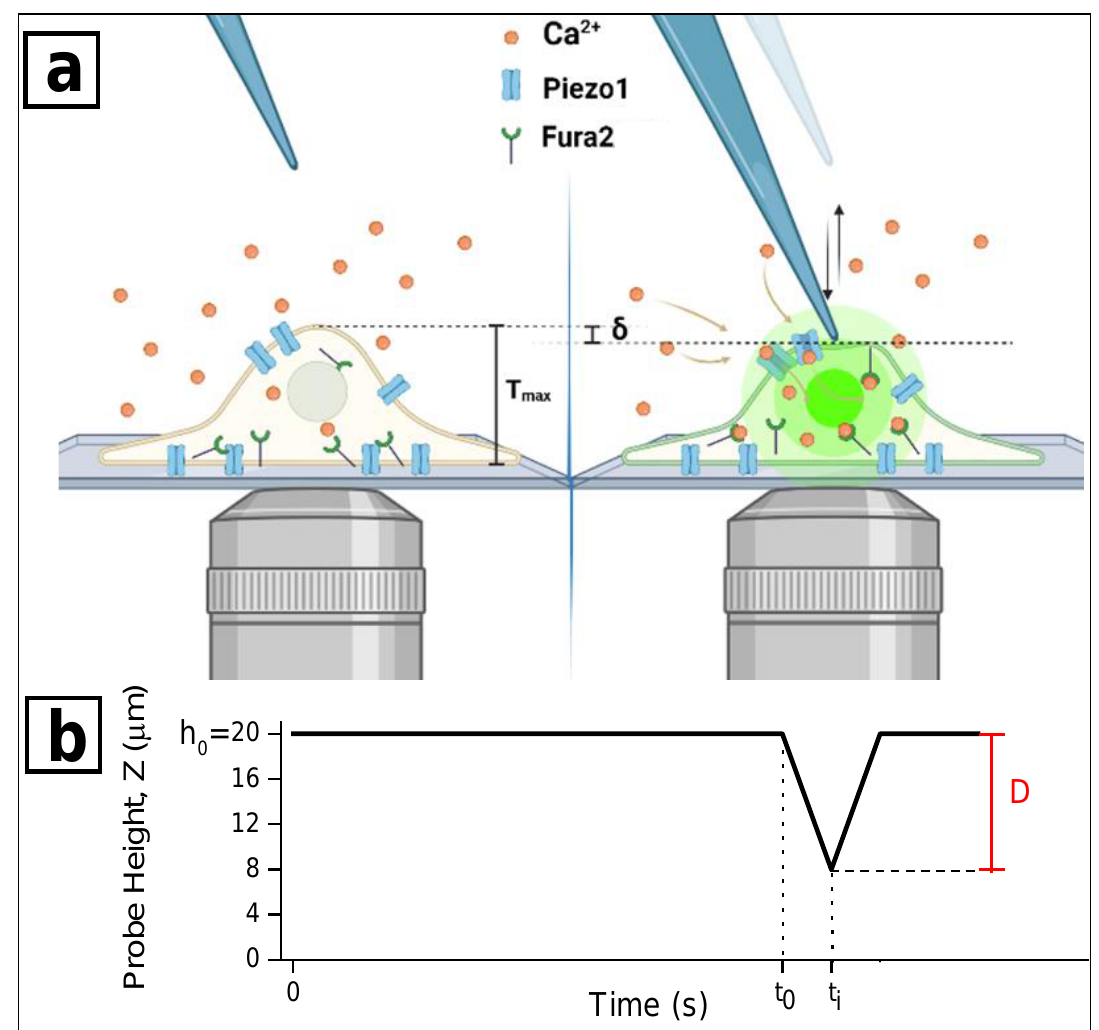
Figure 2. Schematic picture of the single-cell microindentation experiment. ( a ) The perturbation of the cell membrane provokes the opening of the Piezo1 channels, inducing an increase of the intracellular Ca 2+ concentration, which is monitored by the ratiometric fura2-based fluorescence microscopy. ( b ) Timeline of glass probe position Z: the needle tip is initially positioned 20 µ m (h 0 ) above the adhesion plane; cell indentation takes place upon an area of maximum thickness T max corresponding to the nucleus zone. At instant t 0 , the probe begins vertically move downward by a distance D; at the instant t i , the cellular membrane is indented until a depth δ . Since the moving speed of the motion stage is v = 3 μm/s, the time interval Δt = t i − t 0 depends on the probe displacement D, which is Δt = 4 s and D = 12 μm in the figure.